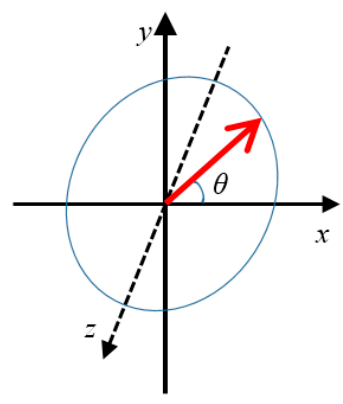
Figure 13. Schematic of degree θ of V iff direction on xz plane (marked by blue ellipse line) in three-dimensional space. (Considering surface from inner curve side to outer curve side as x -positive axis, the grain growth direction from bloom left edge to center as y -positive axis, and casting direction as z -positive axis.)